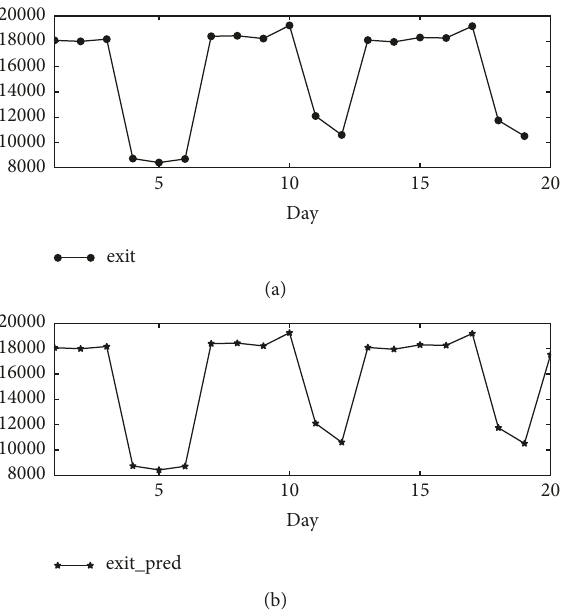
Figure 5: Prediction of daily entrance passenger flow of Dabaishu rail transit station (2 hidden layers).